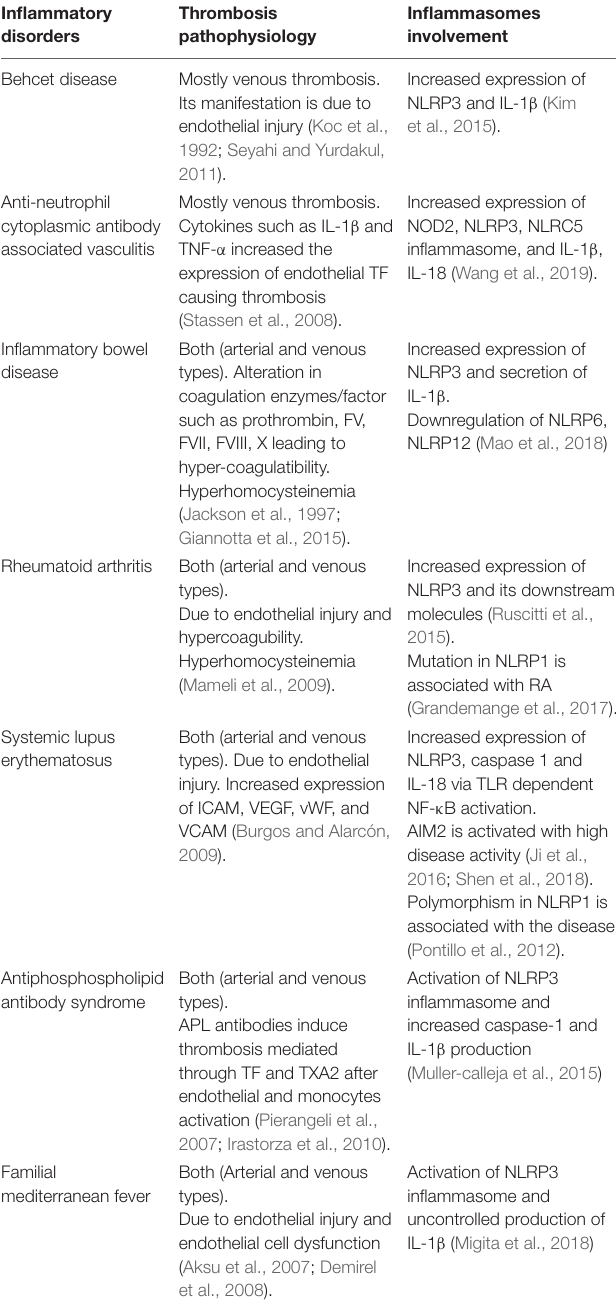
TABLE 1 | Thrombosis associated inflammatory disorders with the involvement of inflammasomes in their